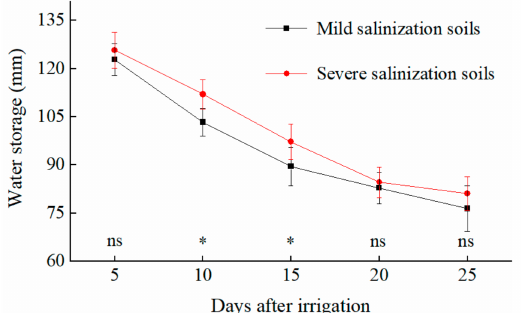
Figure 3. Mean water storage at top 30 cm under different salinization conditions without artificial macropores. Label “ns” means values within the same sampling time are not significantly different, and label “*” means values within the same sampling time are significantly different ( p = 0.05).